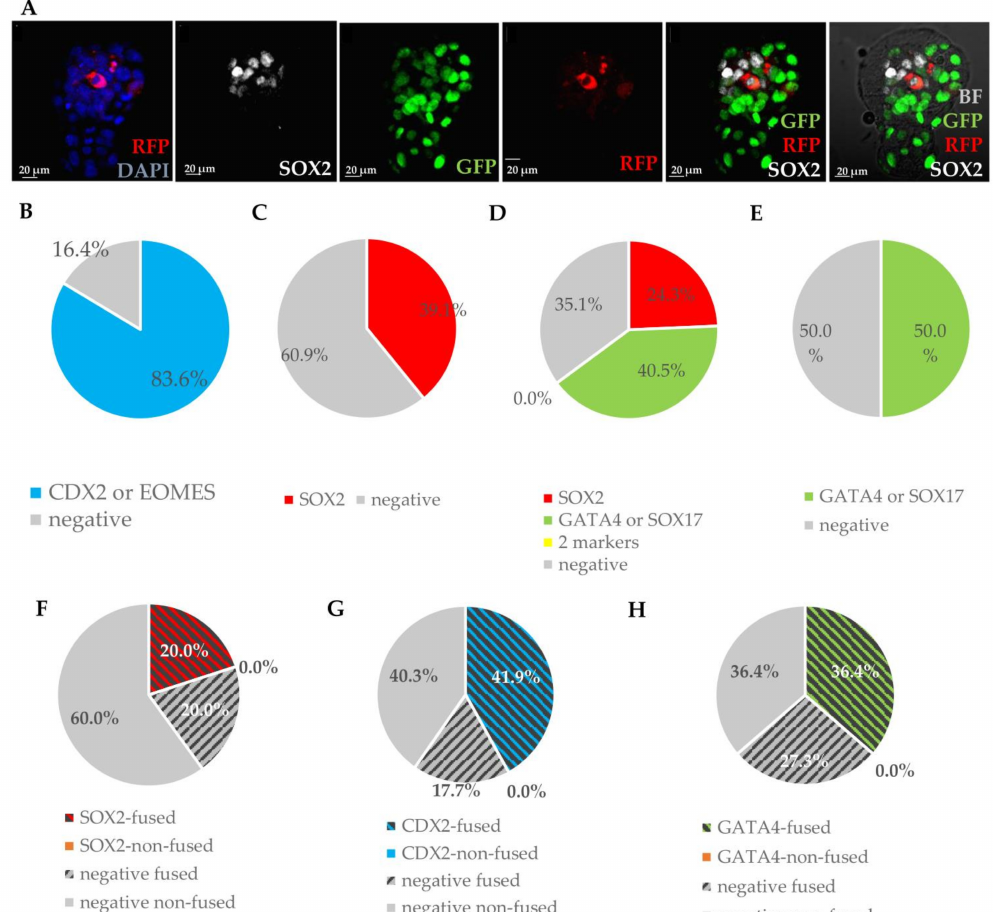
Figure 10. Analysis of marker expression in chimaeras with cumulus cells expressing RFP introduced to embryos. ( A ) Em- bryo with donor cumulus cell integrated with ICM and expressing SOX2 and GFP (cell fused with recipient GFP-expressing cell). ( B ) Cells stained for TE markers: positive for CDX2, EOMES (blue) and negative (grey). ( C ) Cells stained for EPI markers: positive for SOX2 (red) and negative (grey). ( D ) Cells stained for 2 ICM markers (for EPI and PrE marker): positive for SOX2 (red), GATA4, SOX17 (green) and negative (negative); 0.0% stands for the lack of double positive cells. ( E ) Cells stained for PrE markers: positive for GATA4, SOX17 (green) and negative (grey). ( F ) Cells stained for ICM markers: positive for SOX2 fused (red, striped), negative fused (grey, striped), negative, non-fused (grey). ( G ) Cells stained for TE markers: positive for CDX2, fused (blue, striped), negative fused (grey, striped), negative, non-fused (grey). ( H ) Cells stained for PrE markers: positive for GATA4, fused (green, striped), negative fused (grey, striped), negative, non-fused